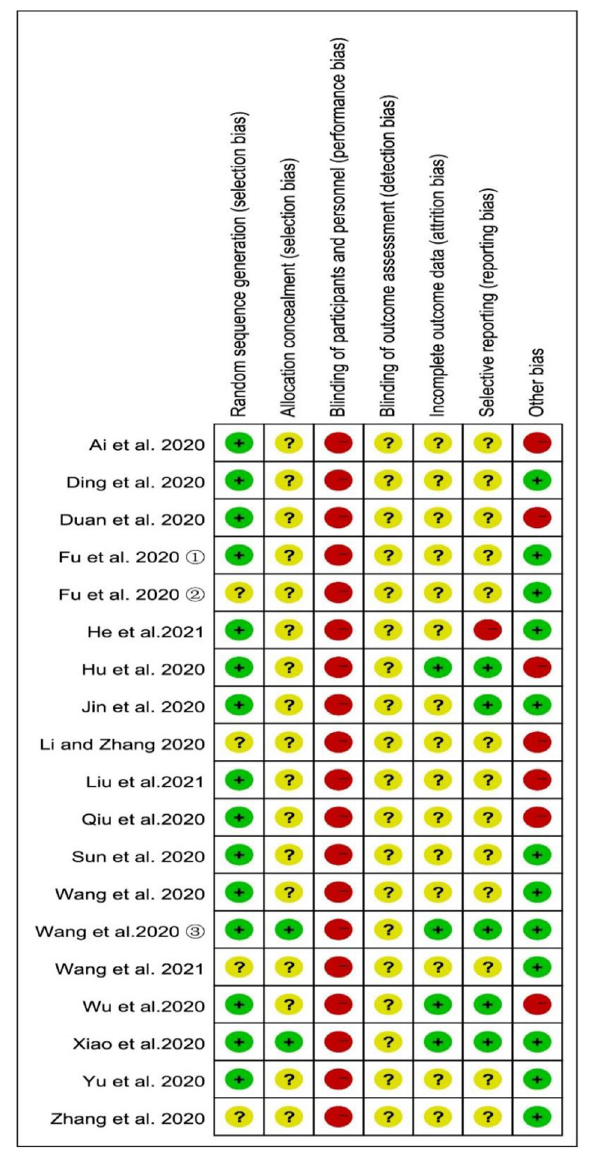
group. Integrated medicine exhibited a significant improvement on the overall effective rate [ RR = 1.17, 95% CI: (1.10, 1.26), p < 0.00001] ( Figure 3